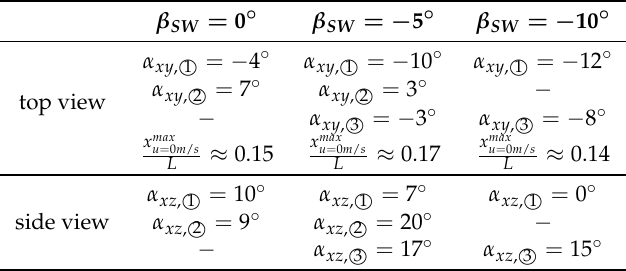
Table 1. Courses of selected vortical structures and wake length values depending on the